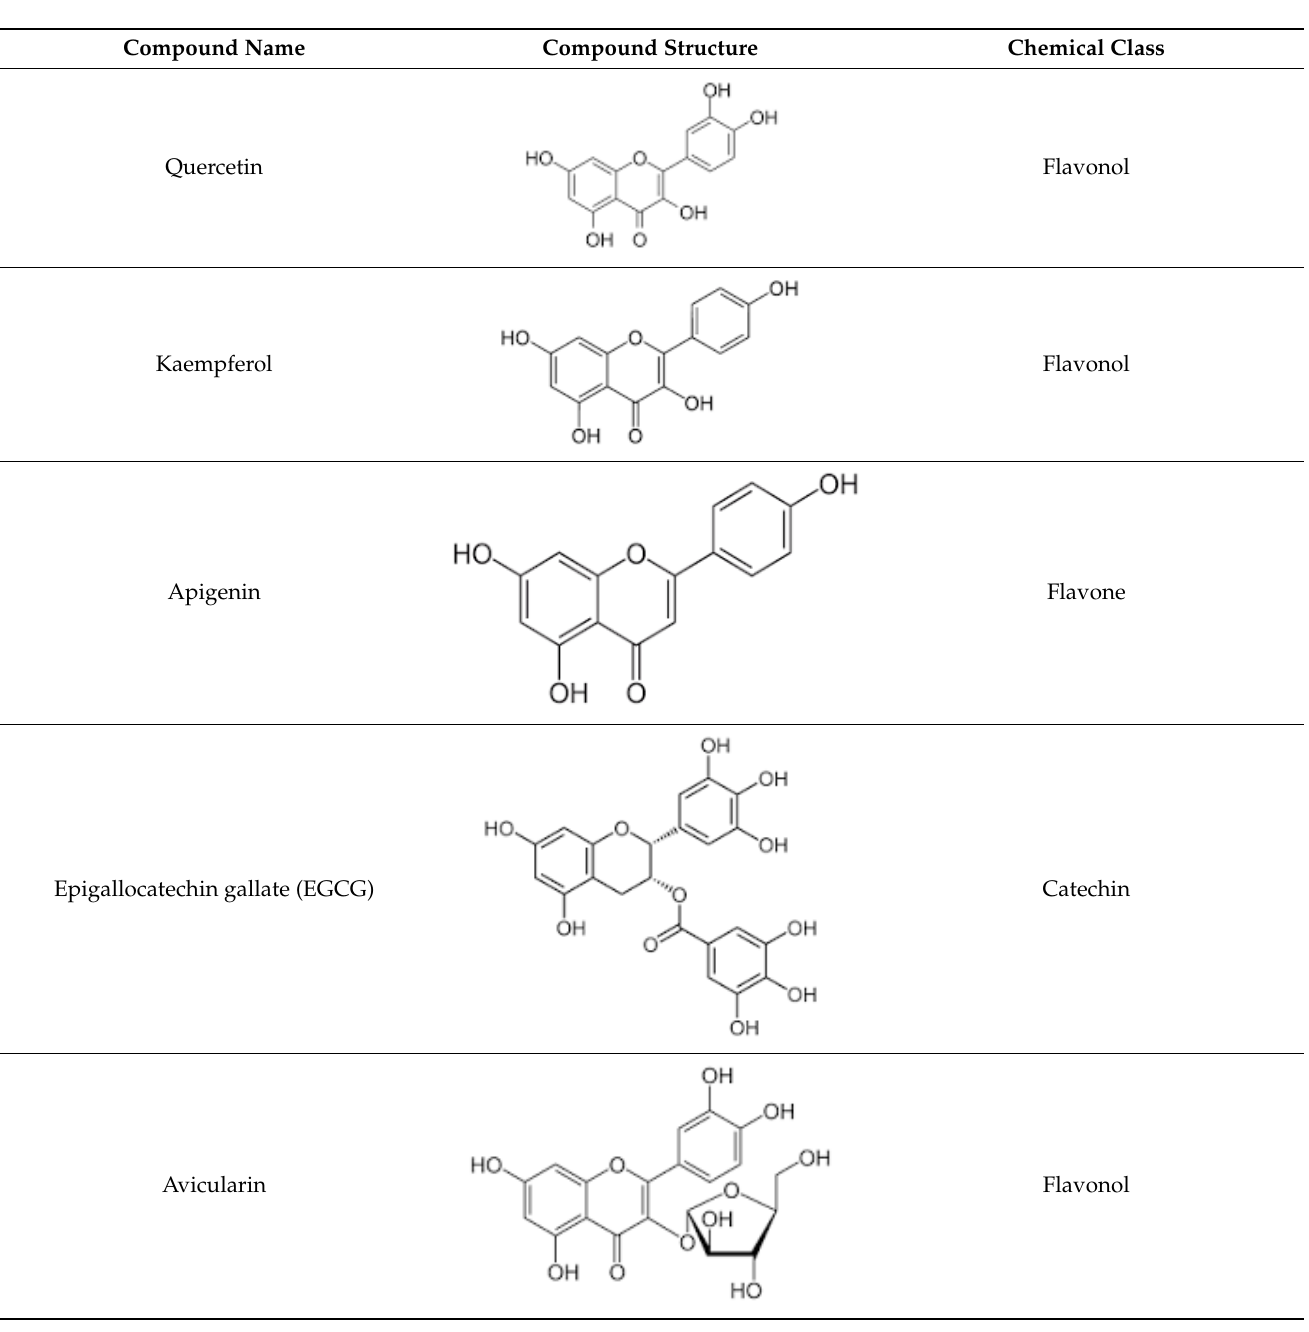
Table 3. Main compounds identified with UPLC-OT-FTMS in K. pinnata extract along with their structure and classification.